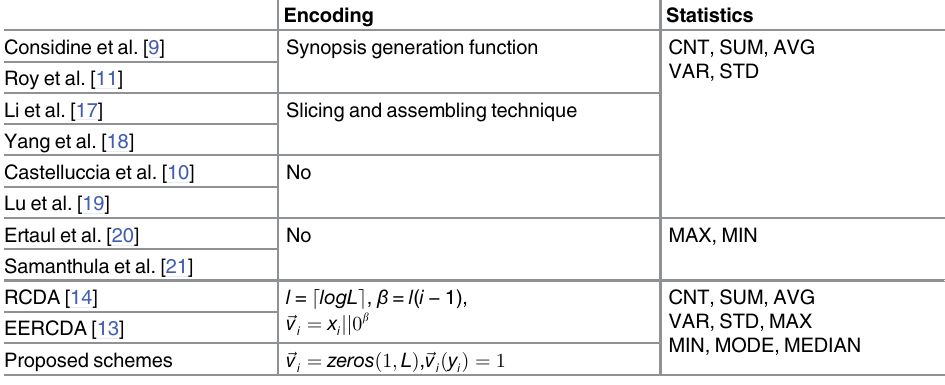
Table 2. Comparison on Statistics Functions and Encoding Method.